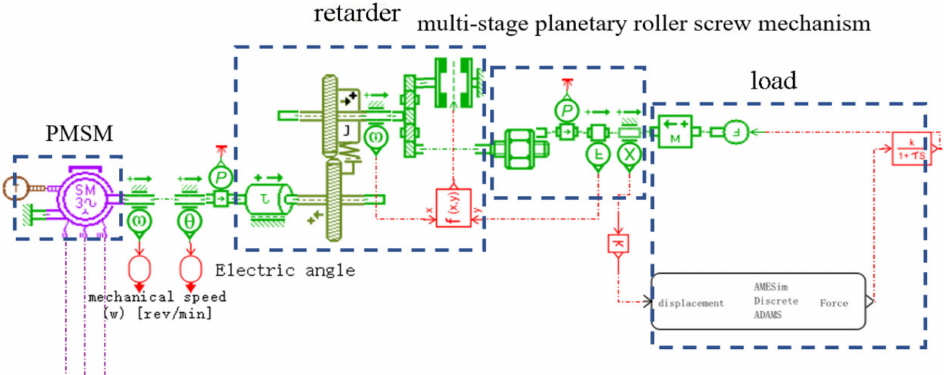
Figure 7. Multi-stage EMA model diagram of